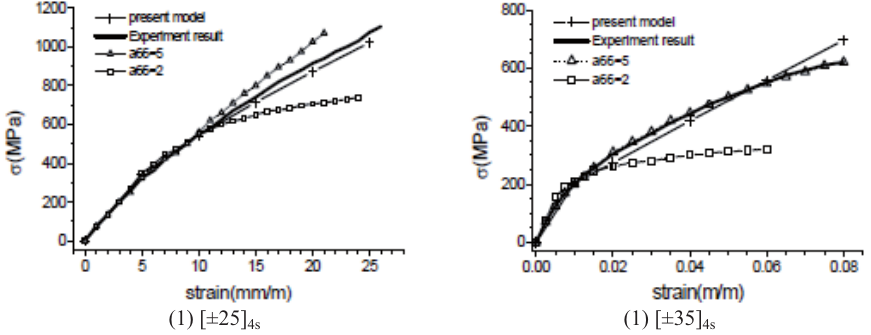
Fig. 4 Comparison of numerical predictions of present orthotropic elasto-plastic FE model and one- parameter model by Meili and Priolo with experimental dates for tension tests